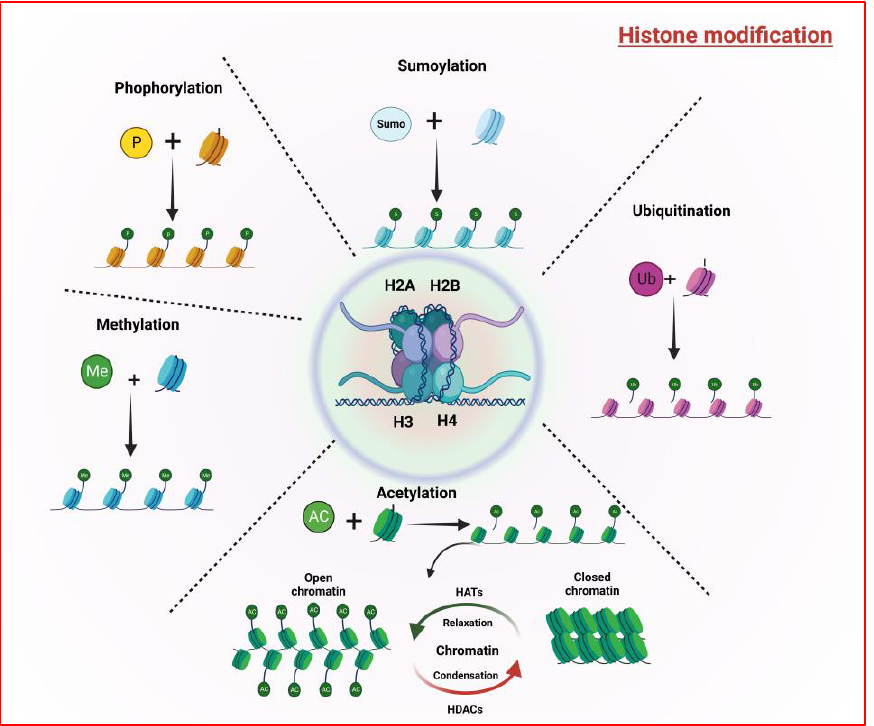
Figure 2. The characteristics of histone modification. (Concept taken from [62] and created with BioRender.com. Last accessed 22 January 2023).